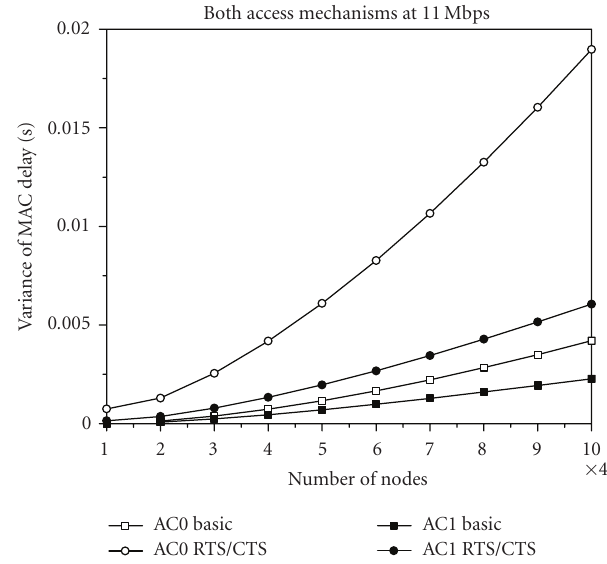
Figure 10: Jitter (second derivative of Z -trasform) is shown for the AC0 and AC1, and for variable number of stations in each AC. The transmission rate is at 11Mbps 802.11b/e.